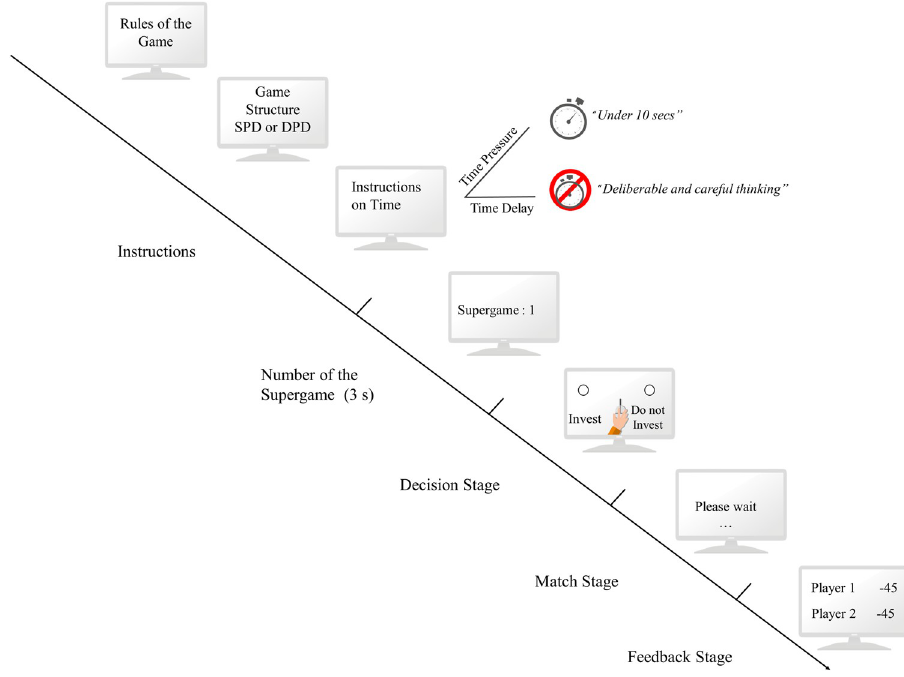
Fig 1. Representation of the game